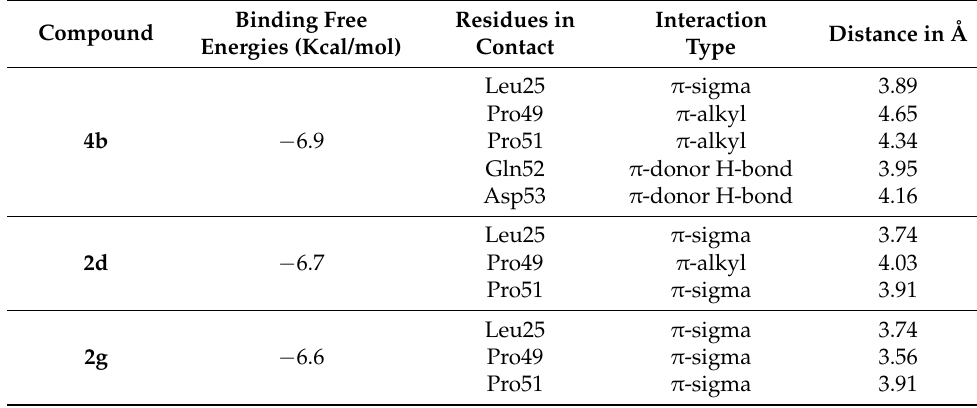
Table 2. Most non bond interactions between Pro-apoptotic Bax protein and top 3 compounds.